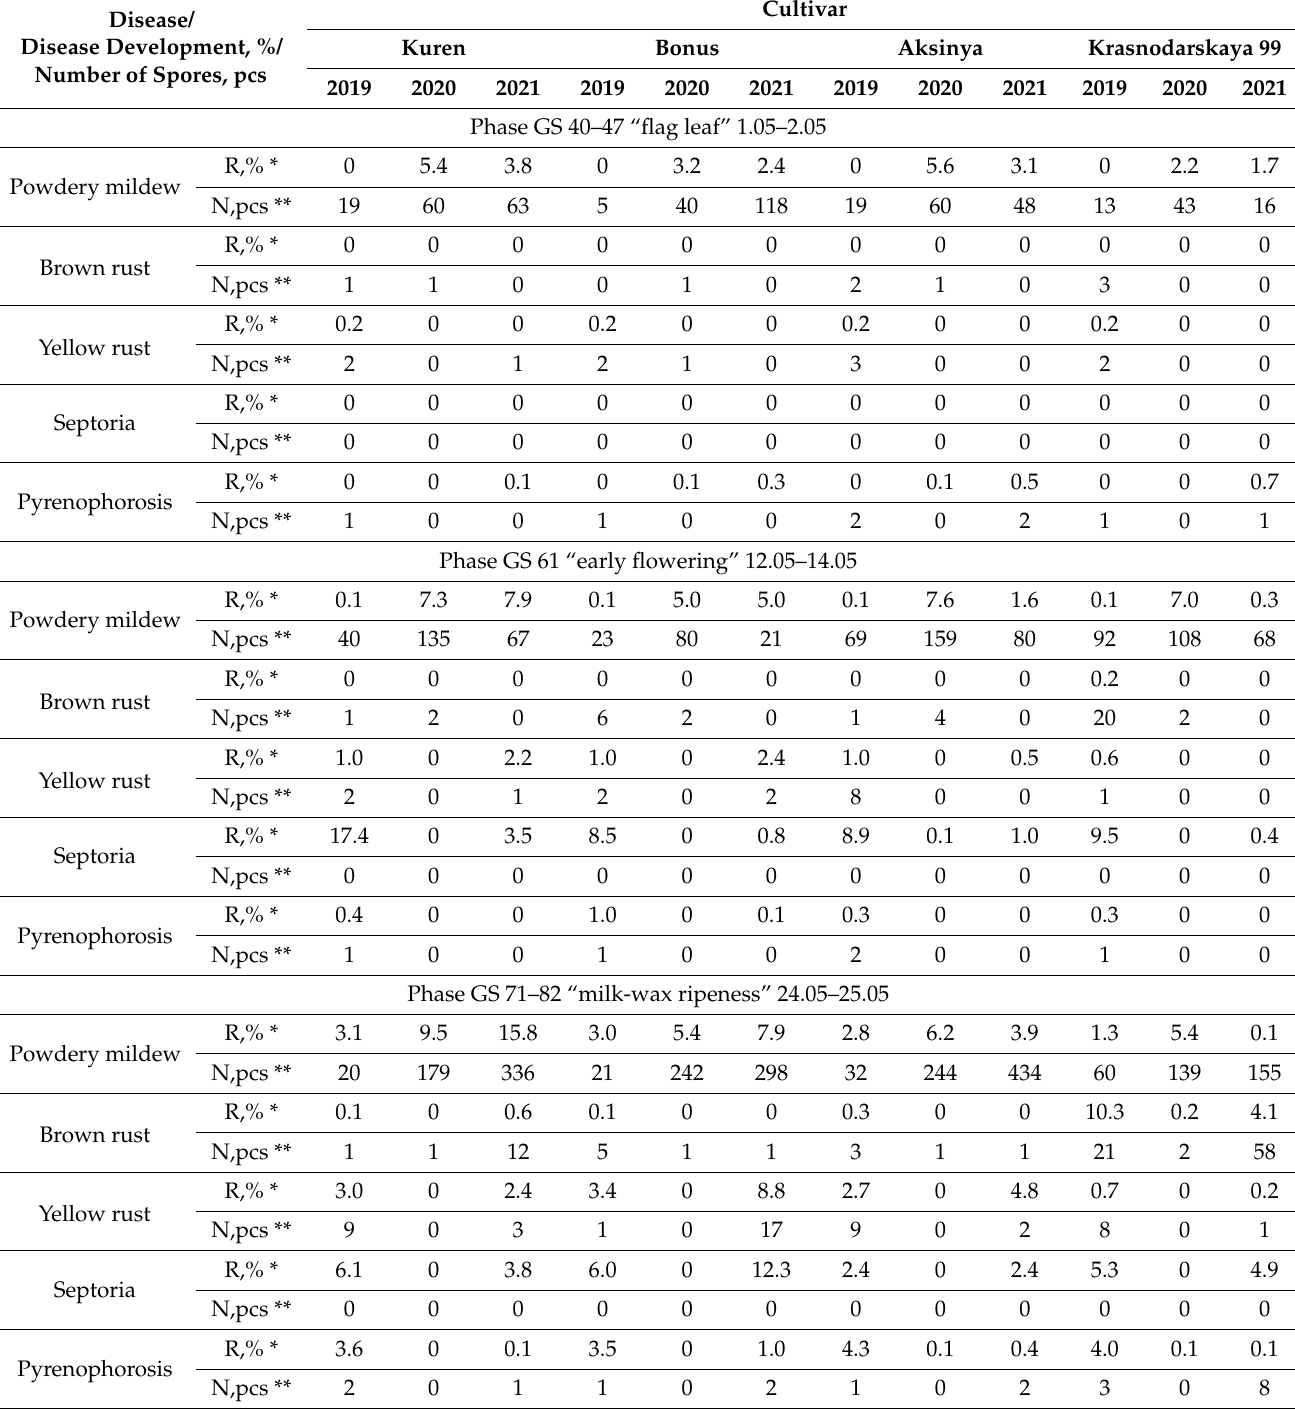
Table 1. Average indicators of disease development and the number of spores on winter wheat crops for three growing seasons